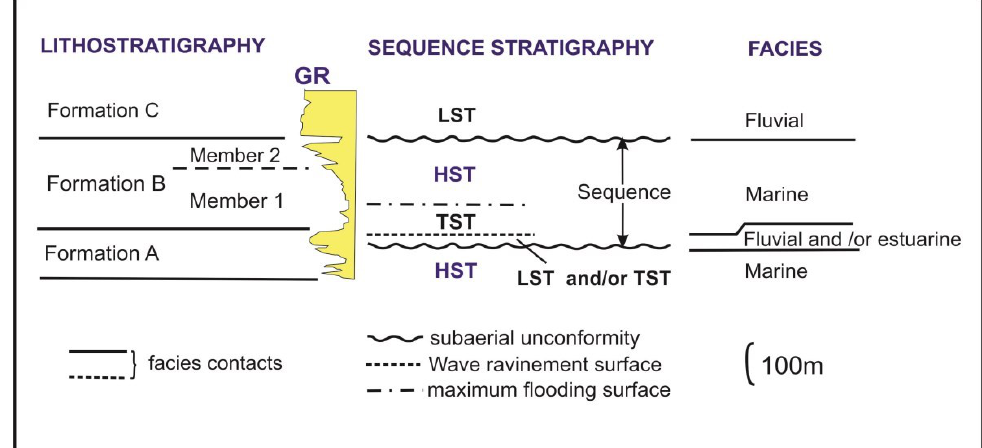
Figure 5. Lithostratigraphic and sequence stratigraphic interpretations of Gamma-Ray (GR) log, modified after Reference